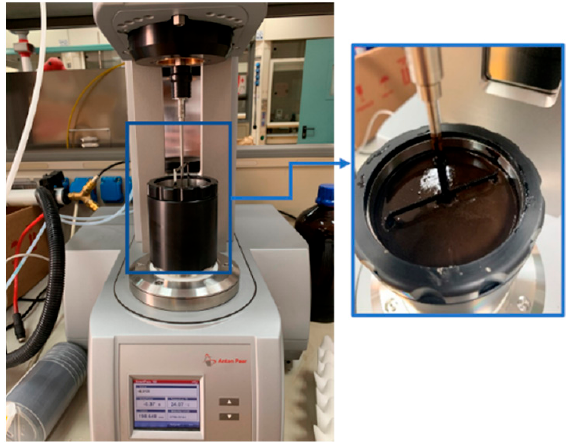
Figure 7. Building material cell for mixing asphalt mastics.